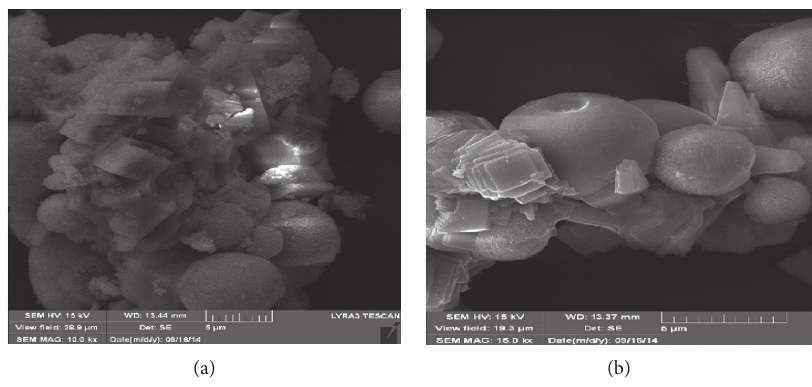
Figure 8: SEM images for deposits of (a) untreated water and (b) UV-treated